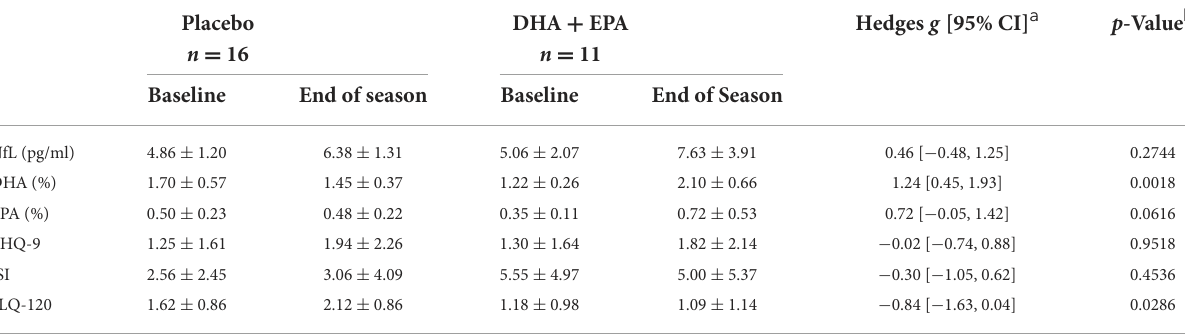
TABLE 2 Serum and behavioral biomarker changes from baseline to end of season in participants completing the trial and all imaging.